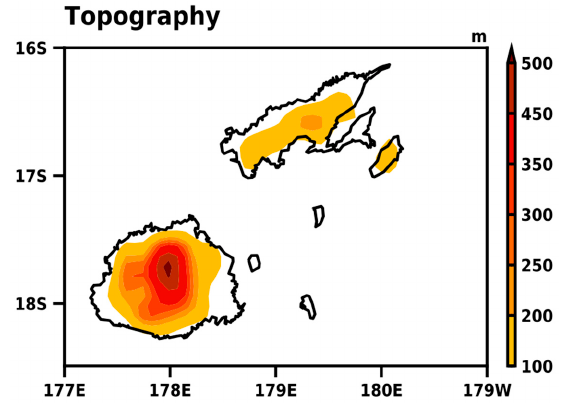
Figure 1. Topography of Fiji’s main islands (color shades are in units of meters).